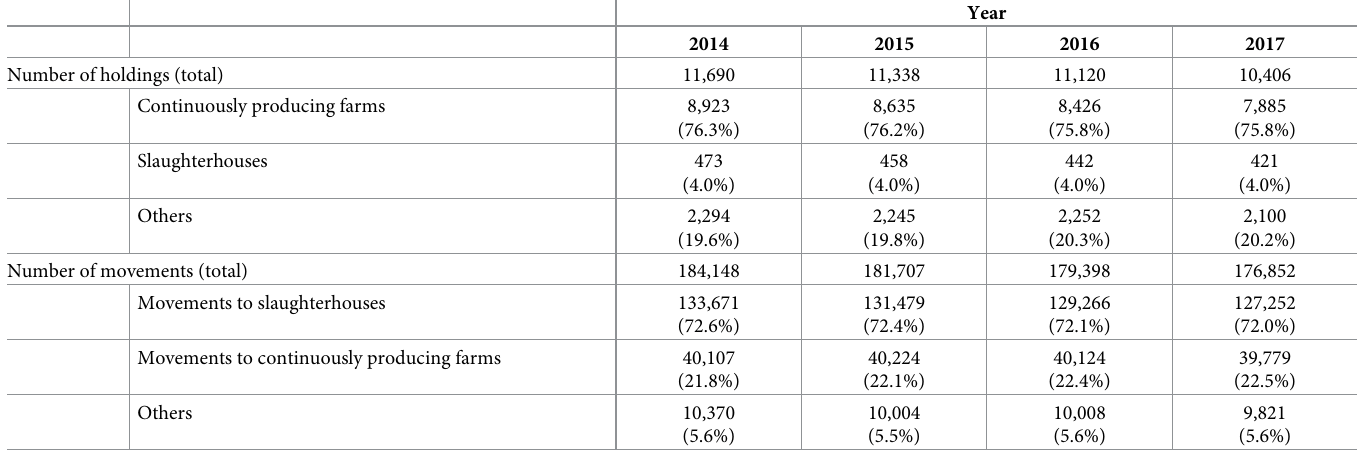
Table 1. Number of holdings and number of movements in AMD over the observation period (2014–2017). ‘Others’ includes different holding types such as trading companies, markets, and veterinary